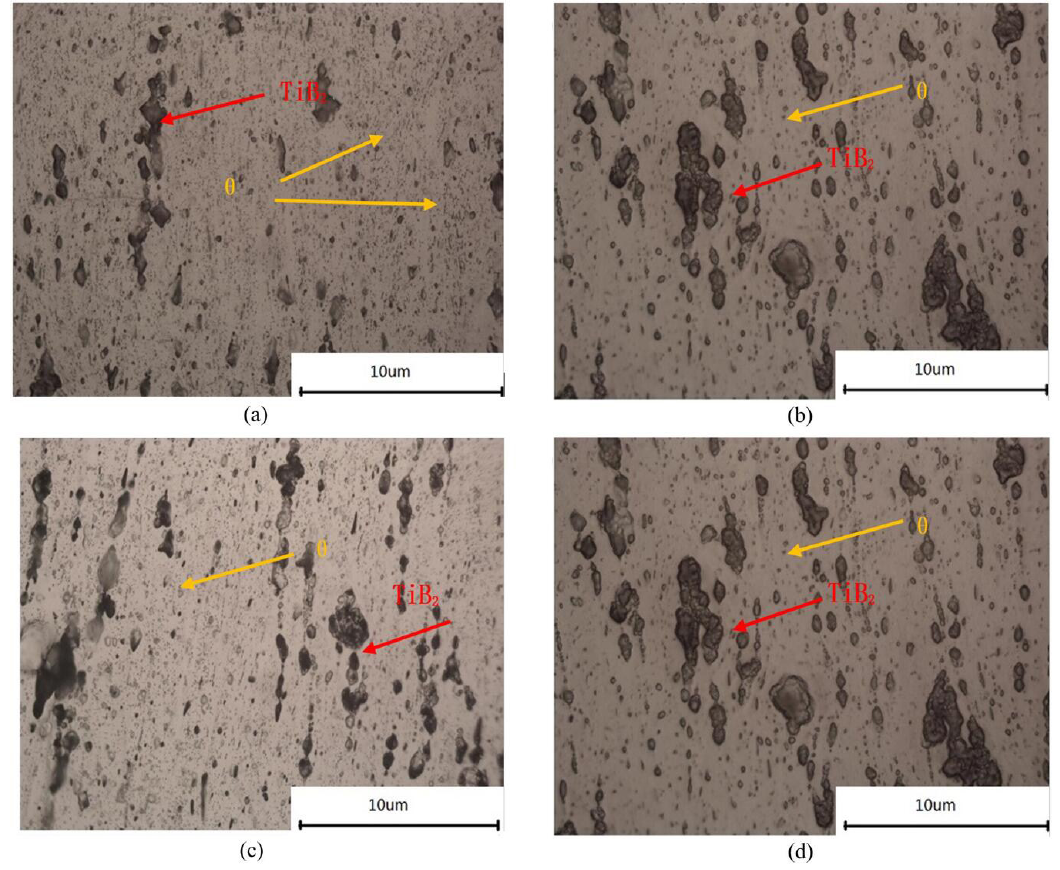
Figure 15. The microstructures of the specimens at the strain rate of 1s -1 and different temperatures: (a) 350°C; (b) 400°C; (c) 450°C; (d)